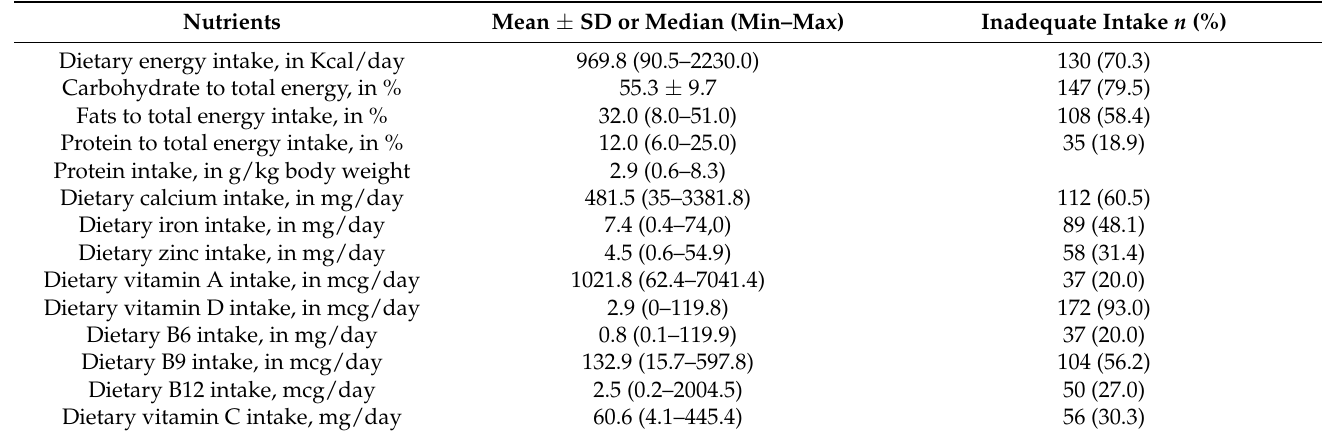
Table 3. Nutrient intake of children aged 6–36 months ( n = 185).